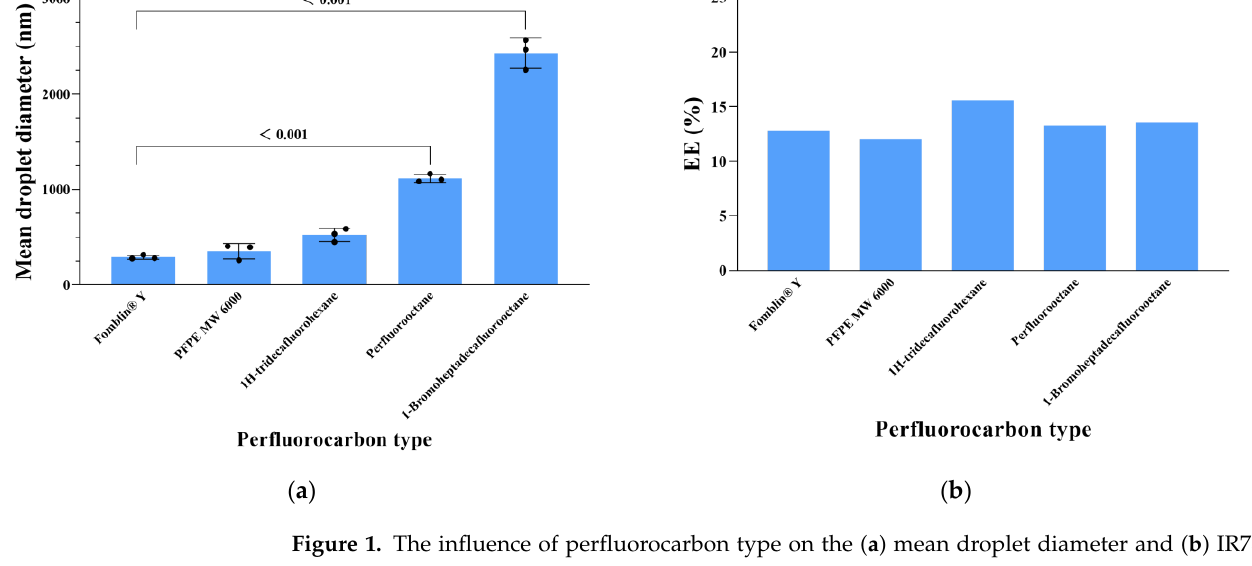
Figure 1. The influence of perfluorocarbon type on the ( a ) mean droplet diameter and ( b ) IR780 EE of emulsions. Values are expressed as mean ± SD (n = 3). Each dot represents an independent experiment. The p values vs. indicated groups are presented.